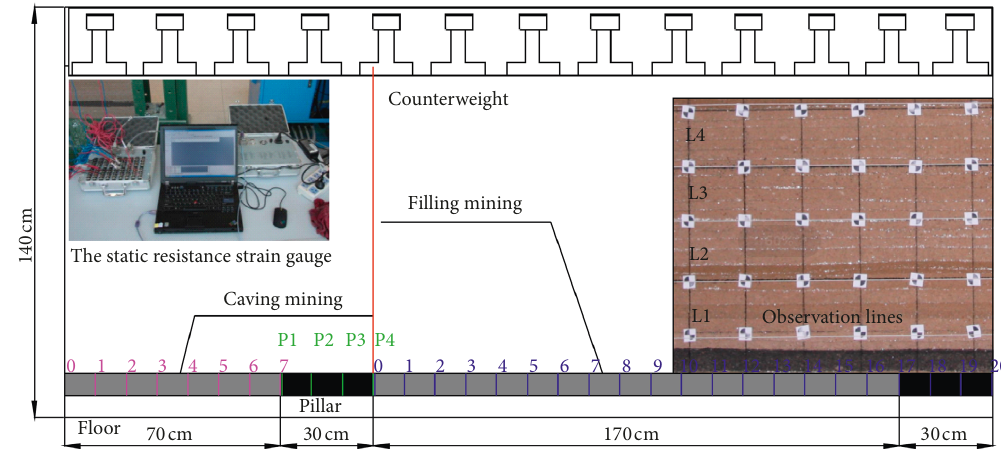
Figure 6: Physical model of filling